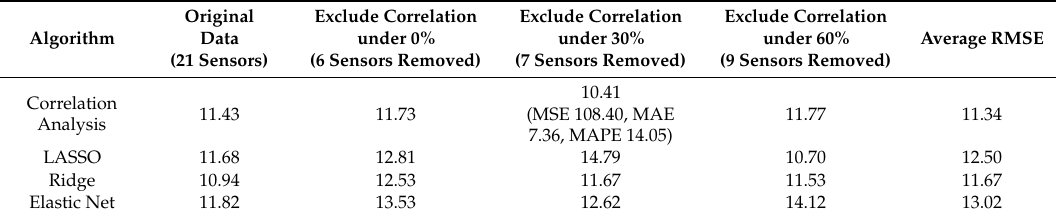
Table 5. RUL prognosis RMSE result with feature selection method.